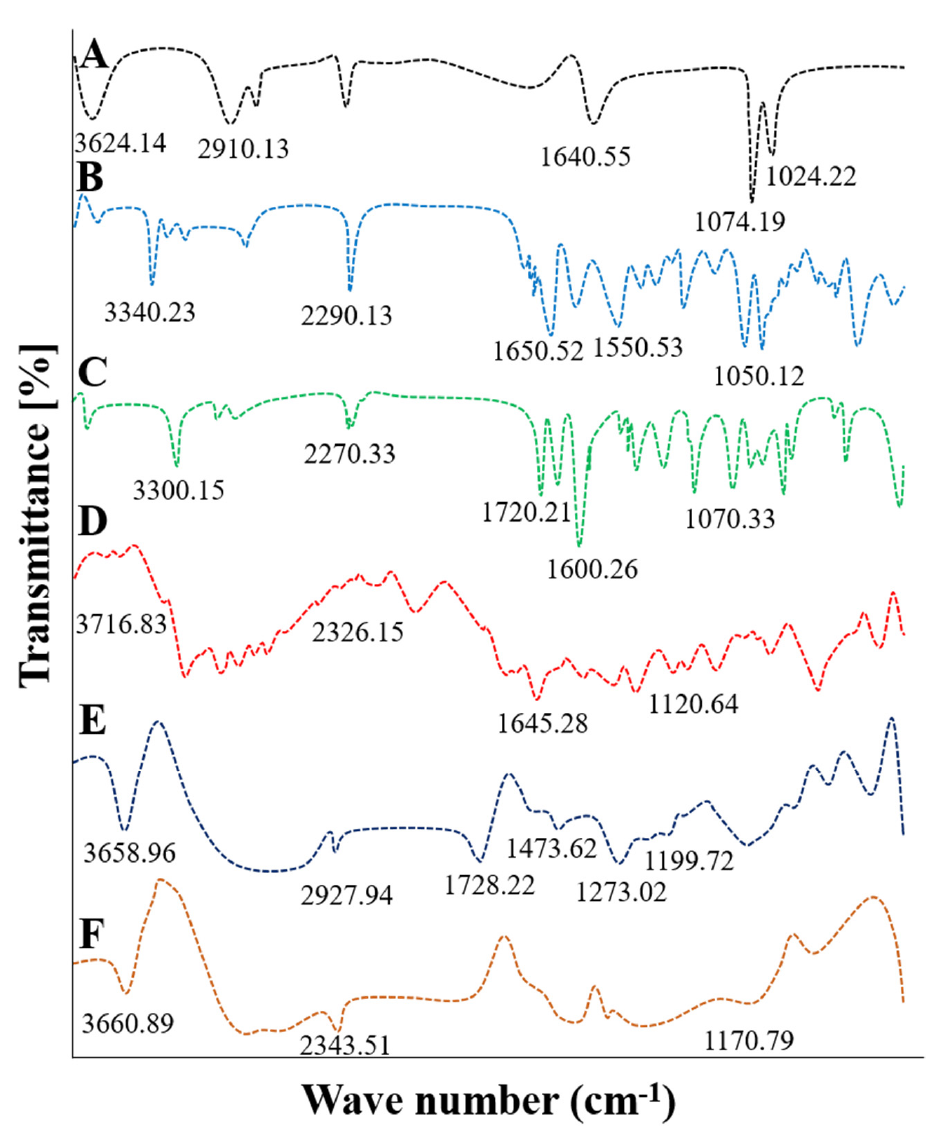
Figure 1. FTIR spectra of HP β CD ( A ), cytarabine ( B ), MBA ( C ), physical mixture ( D ), unloaded hydrogels ( E ) and cytarabine-loaded hydrogel network ( F ).